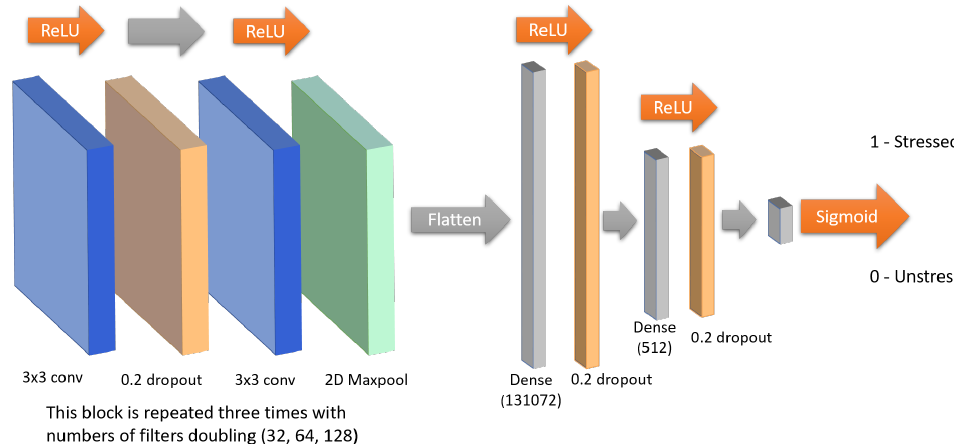
Figure 4. Architecture of our CNN consisting of three repeating blocks of a convolutional layer, a max-pooling layer, a convolutional layer and a dropout layer. The output consists of one node with a sigmoid activation function representing the two classes—stressed and